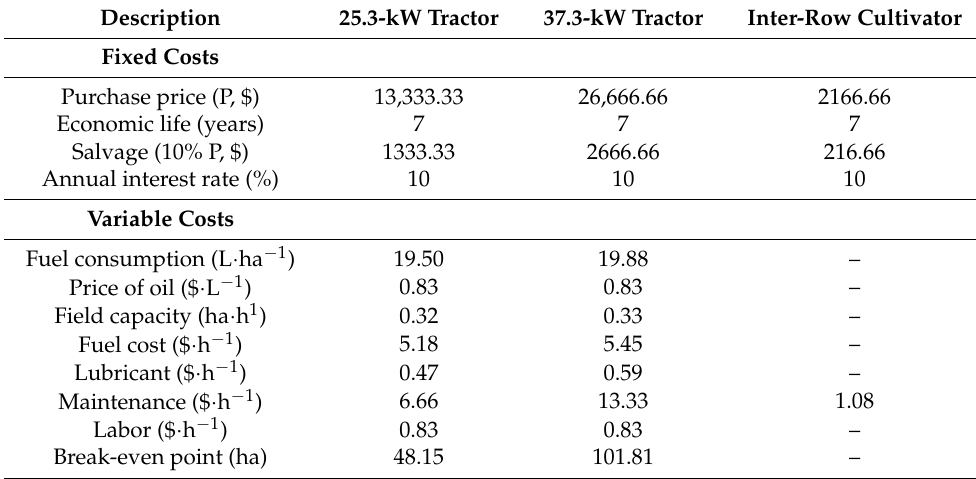
Figure 10. Break-even points of a tractor and an inter-row cultivator with tractors operating at 25.3 kW and 37.3 kW. Table 6. Economic analysis of a tractor and an inter-row cultivator.